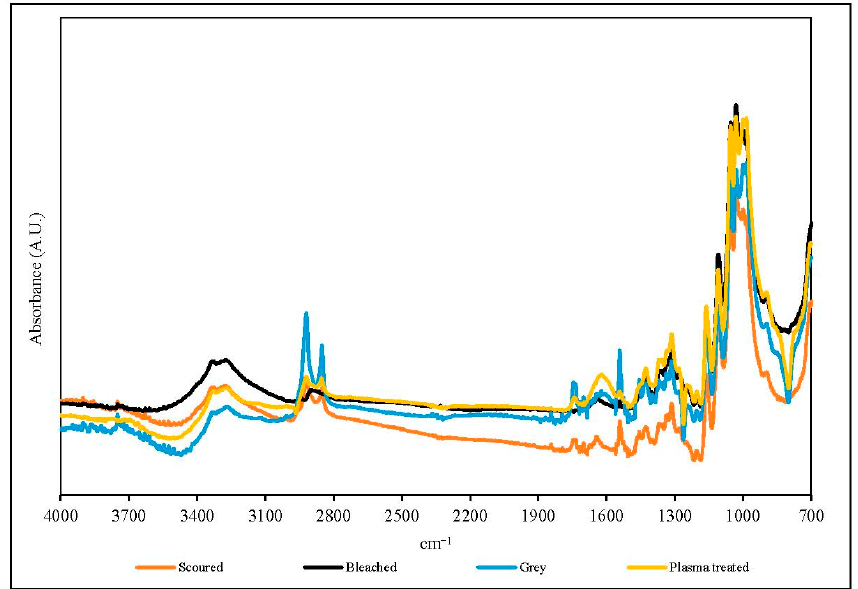
Figure 12. FTIR-ATR spectra of interlock fabrics (plasma condition: 150 W output power and 0.4 L/min oxygen flow rate).